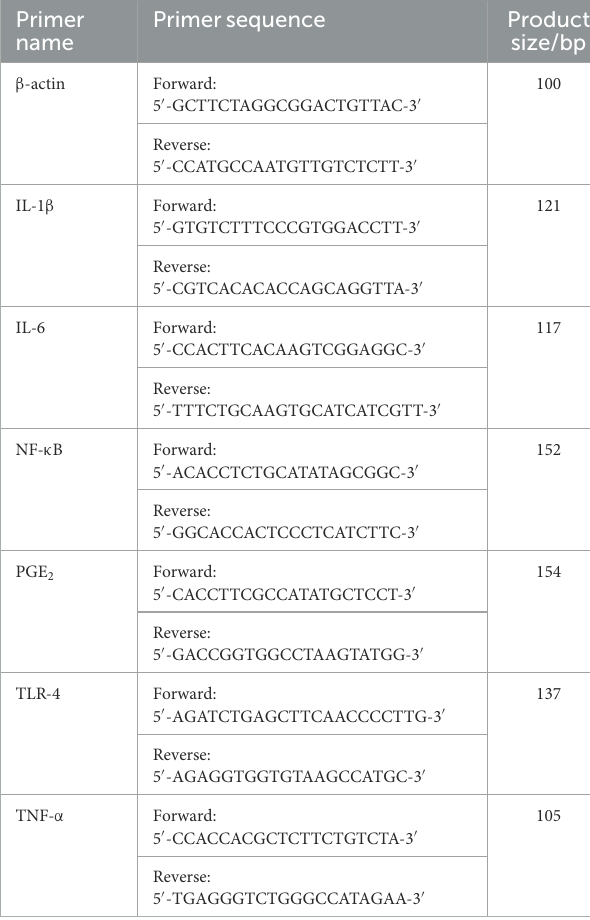
TABLE 1 Primer sequences of